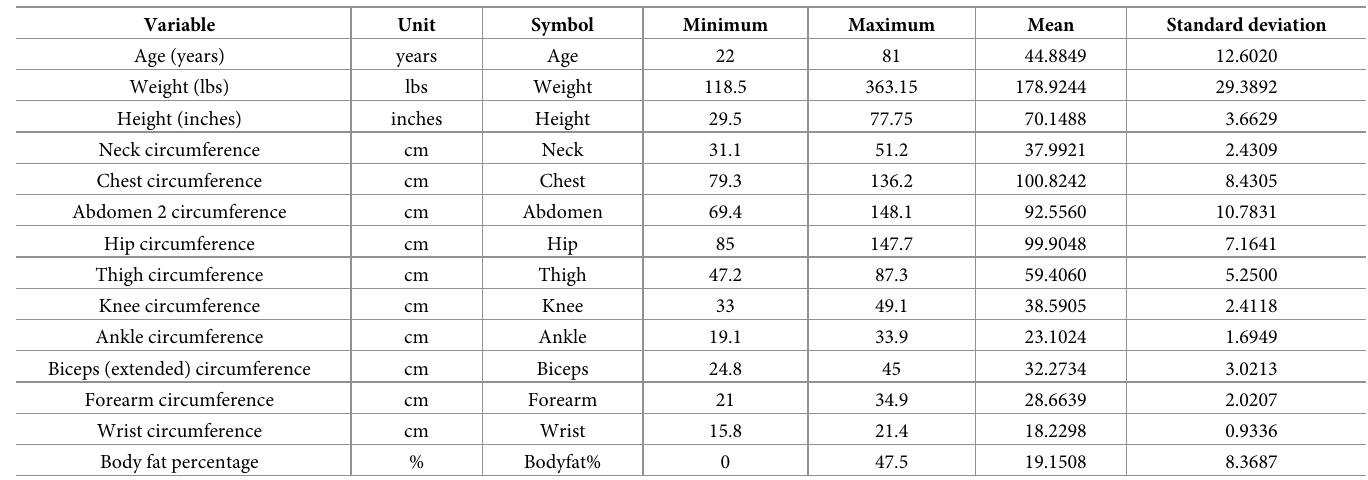
Table 2. Statistical properties of Case 1’s body fat